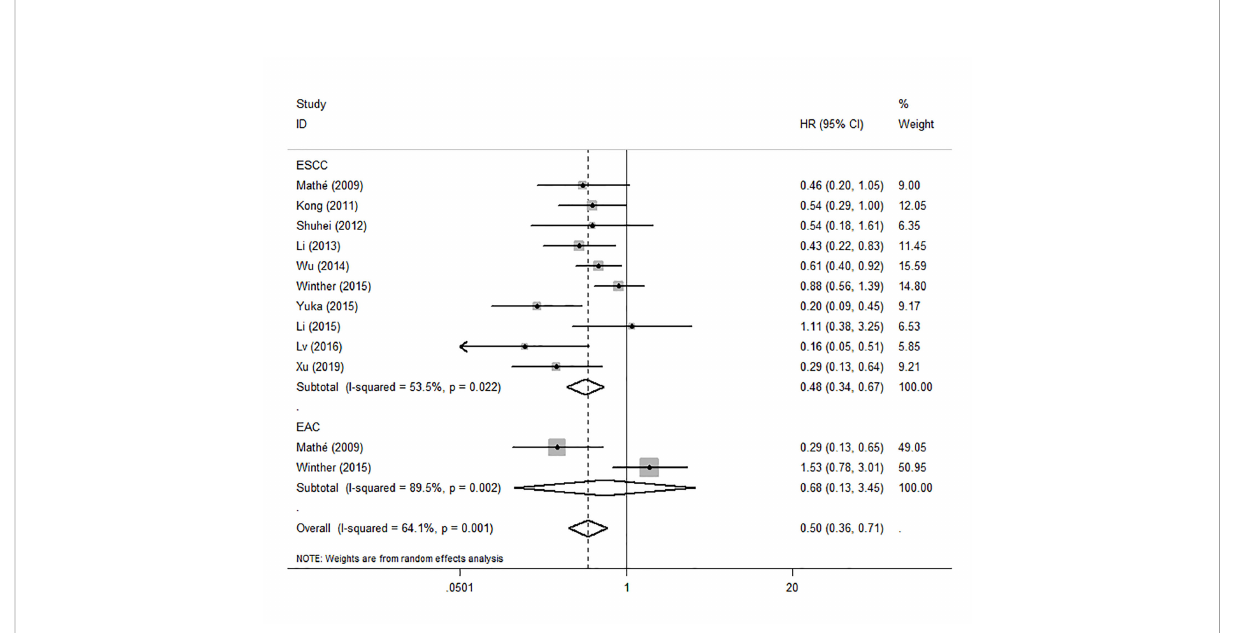
FIGURE 7 Forest plot showing subgroup analysis of the selected studies about the prognostic signi fi cance of mir-375 in patients with different cancer